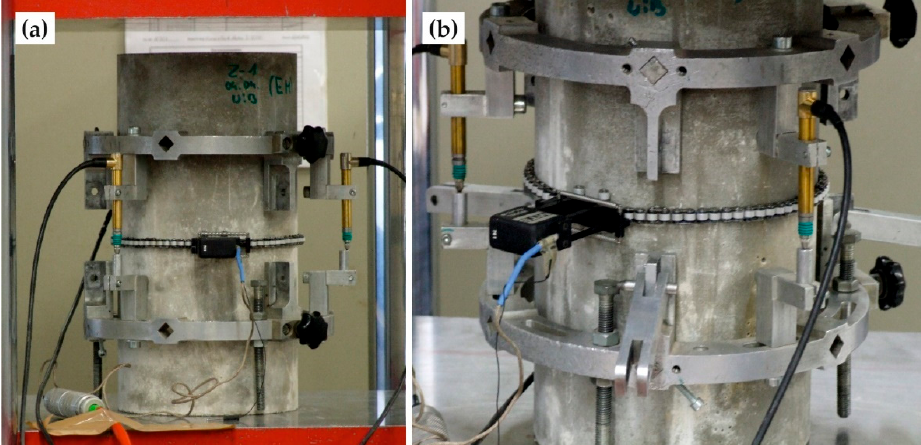
Figure A3. Testing the static modulus of elasticity on grouting mortar under compression. ( a ) Specimen in test facility (Form+Test Prüfsysteme, ALPHA 4 ‐ 3000) and ( b ) detail showing the measuring chain and inductive displacement transducers (after [31]).